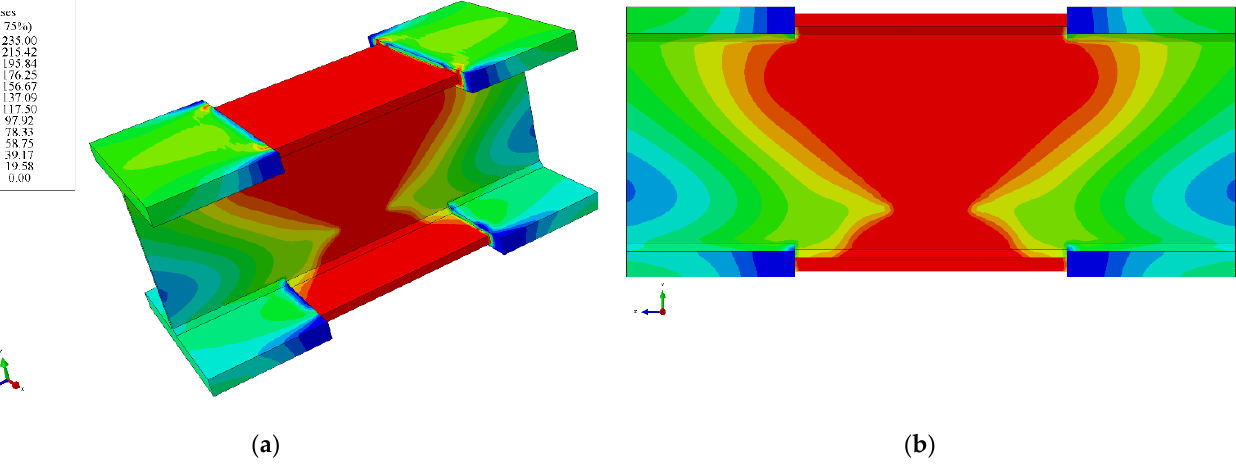
Figure 17. von Mises’ stress map (MPa) for LRPD HEA300 (DP1) at the ultimate loading condition: ( a ) perspective view; ( b ) lateral view.